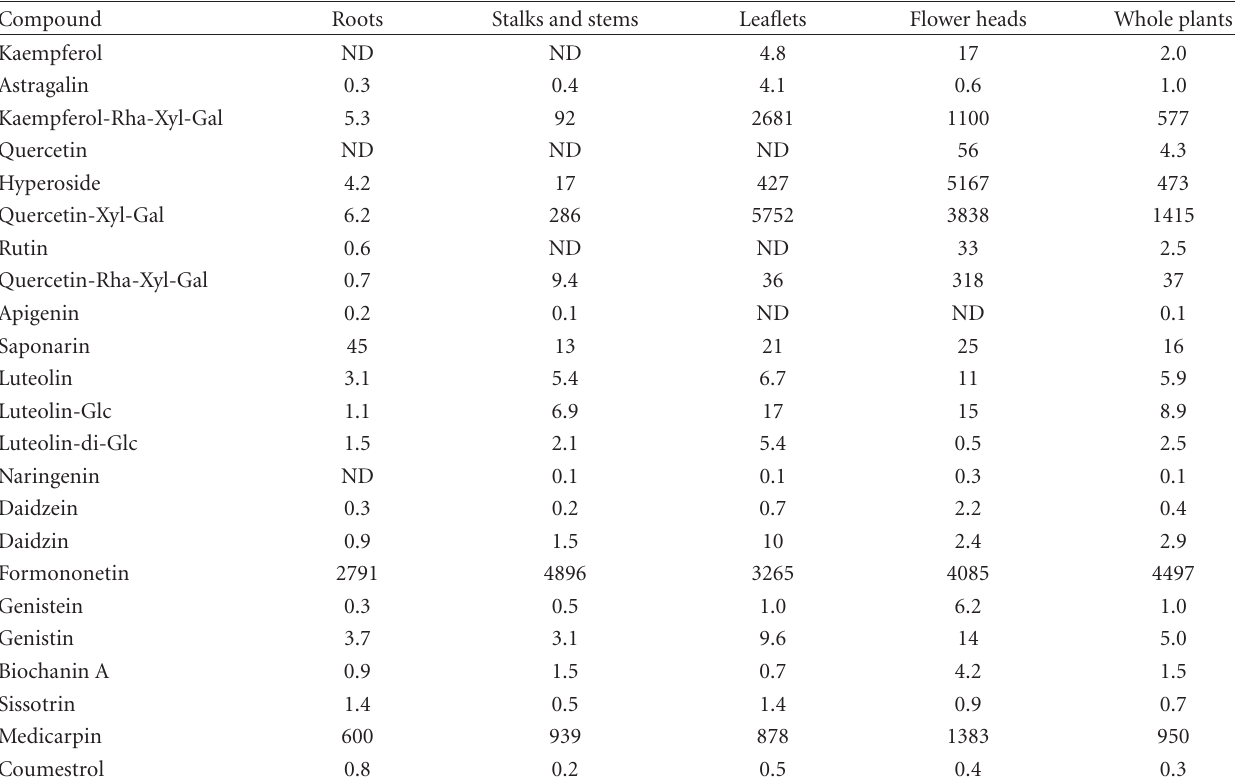
Table 5: Concentrations in plant tissues and whole plants before incorporation ( μ mol/kg dry weight). Values represent the mean of two replicate analyses. Compound Roots Stalks and stems Leaflets Flower heads Whole